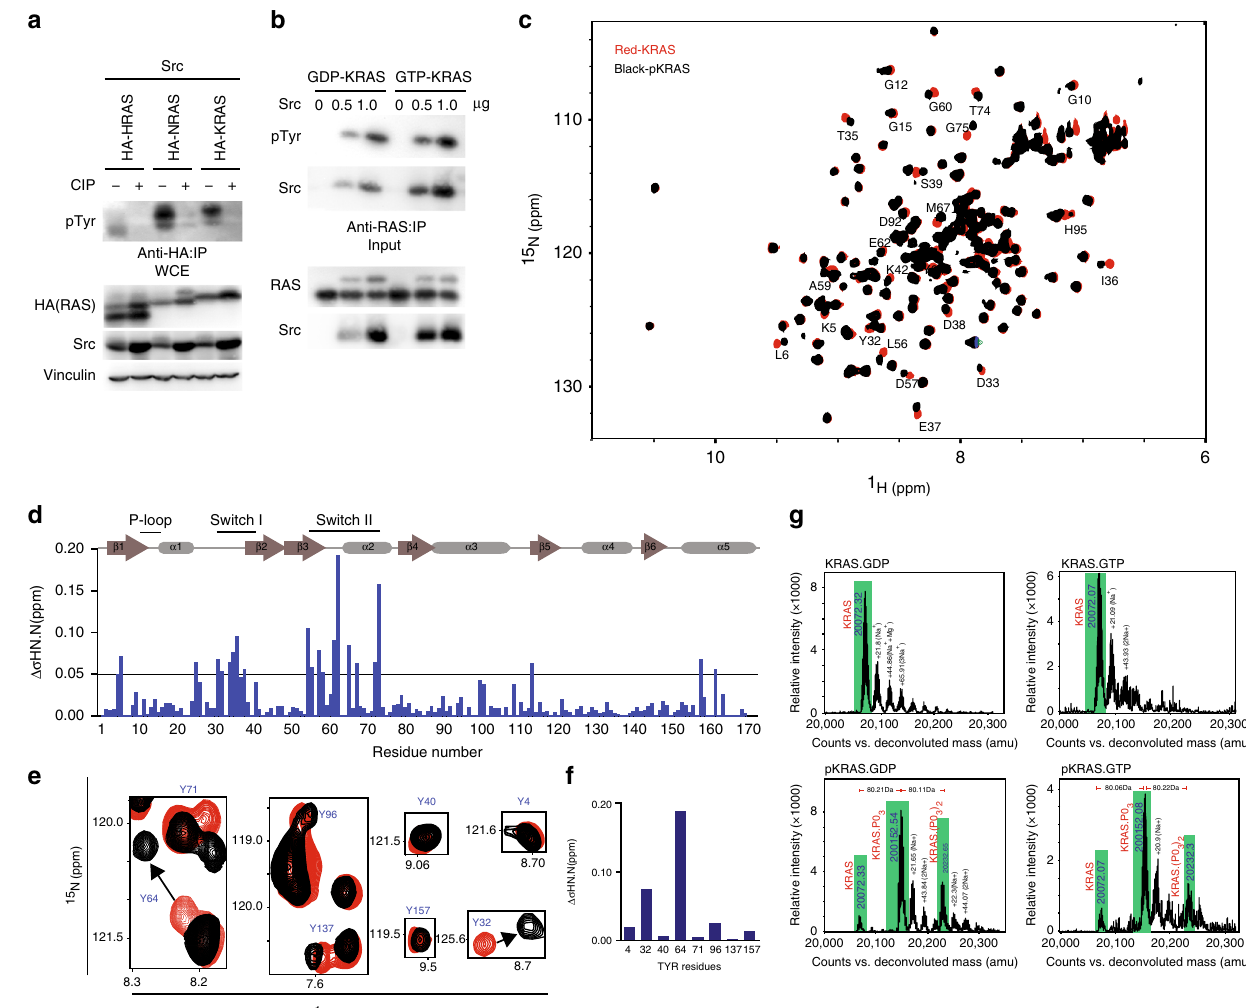
Fig. 1 Src phosphorylation of KRAS alters the structure of the switch regions. a HEK293 cells transfected with the indicated plasmids were lysed, treated with ( + ) or without ( − ) calf intestinal alkaline phosphatase (CIP), immunoprecipitated, and immunoblotted with the indicated antibodies. b Puri fi ed recombinant human GDP- and GTP-bound KRAS protein were subjected to in vitro kinase assay using puri fi ed recombinant Src cat kinase and were immunoprecipitated and immunoblotted with the indicated antibodies. c An overlay of 2D 1 H- 15 N HSQC spectra of unmodi fi ed KRAS-GDP (red) and pKRAS-GDP phosphorylated by Src (black). The labeled residues are residues with notable chemical shift perturbation. d Histogram mapping the backbone NH chemical shift changes caused by Src phosphorylation. Chemical shift changes of the N and NH peaks of the unmodi fi ed vs. phosphorylated cross- peaks in the 2D 1 H- 15 N HSQC spectra were calculated using the formula Δ δ NH.N(ppm) = √ ( 〖 ( Δ H) 〗 ^2 + 〖 ( Δ N/5) 〗 ^2) and plotted against residue number. e Overlay of 1 H- 15 N HSQC spectra of 15 N-KRAS tyrosine peaks before (red) and after (black) phosphorylation. The residue numbers are indicated in blue and the arrows indicate the direction of the chemical shift change. Full spectra are shown in c . f Chemical shift changes of the KRAS tyrosine residues induced by phosphorylation. g Upper panel: Mass spectra of unmodi fi ed GDP-loaded KRAS (left) and KRAS loaded with the non-hydrolyzable GTP analog GMPPNP (right). The major peak of KRAS is shaded green, and the higher molecular weight peaks ( + 22 Da) correspond to sodium adducts (the predicted molecular mass of 15 N-KRAS (residues 1 – 173 C118S) is 20074.35 Da). Lower panel: Mass spectrum of GDP-loaded pKRAS (left) and GTP-loaded pKRAS (right) following treatment with Src in vitro. The three peaks highlighted in green correspond to unmodi fi ed KRAS, KRAS phosphorylated at one site ( + 80 Da) and KRAS phosphorylated at two sites ( + 160 Da). The immunoblot data are representative of at least three independent